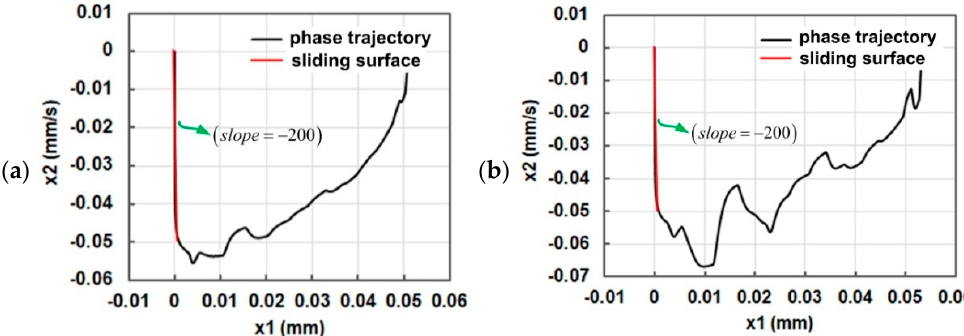
Figure 9. Phase trajectory. ( a ) Phase trajectory of the system with A-level road surface as the unmodeled dynamics. ( b ) Phase trajectory of the system with C-level road surface as the unmodeled dynamics.